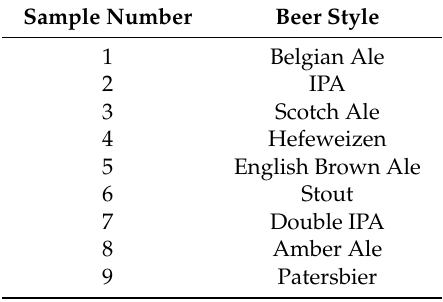
Table 1. Beer sample